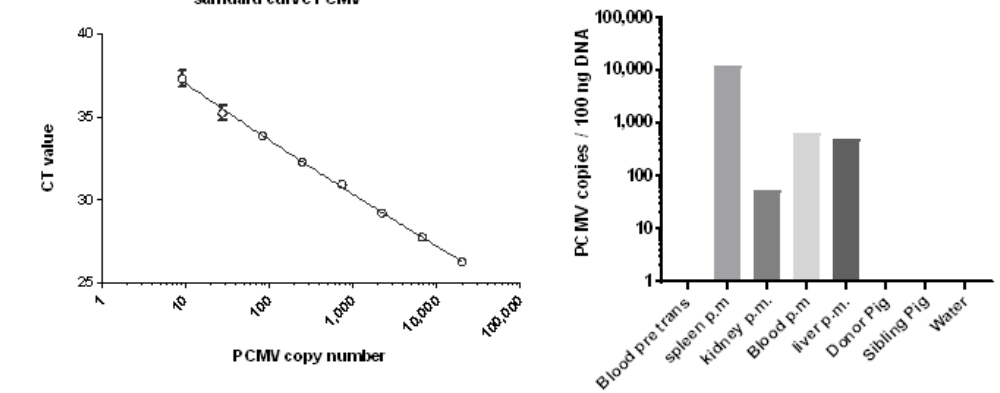
Figure 4. Standard curve for the estimation of the copy number of PCMV and copy numbers of PCMV in different organs of baboon 64 after orthotopic heart transplantation. DNA was isolated from different organs and tested using real-time PCR. Blood pre trans, blood before transplantation; p.m., post mortem; sibling pig is pig 5157; note the logarithmic scale of the axis.